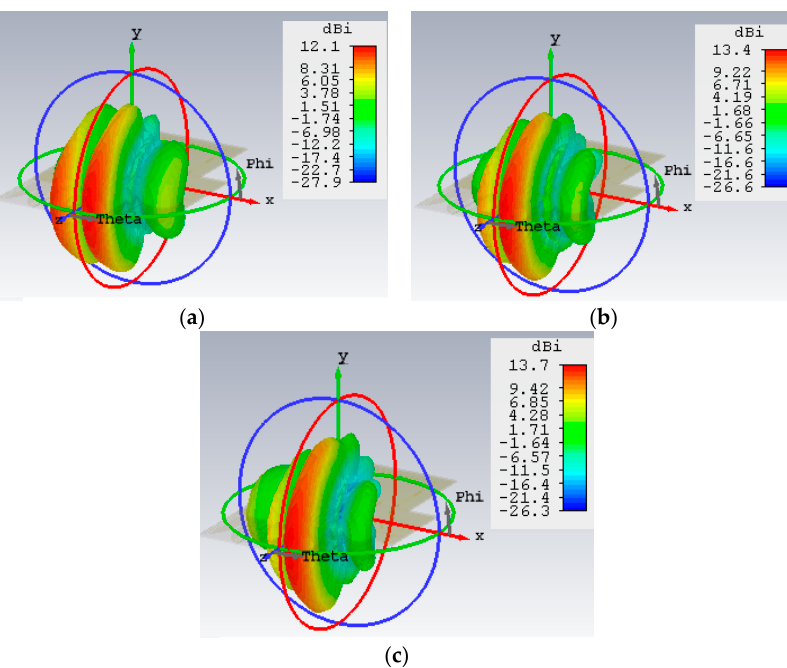
Figure 21. ( a ) Power levels of four port power divider; ( b ) reflection coefficient of Vivaldi antenna array with four-way SIW power divider.